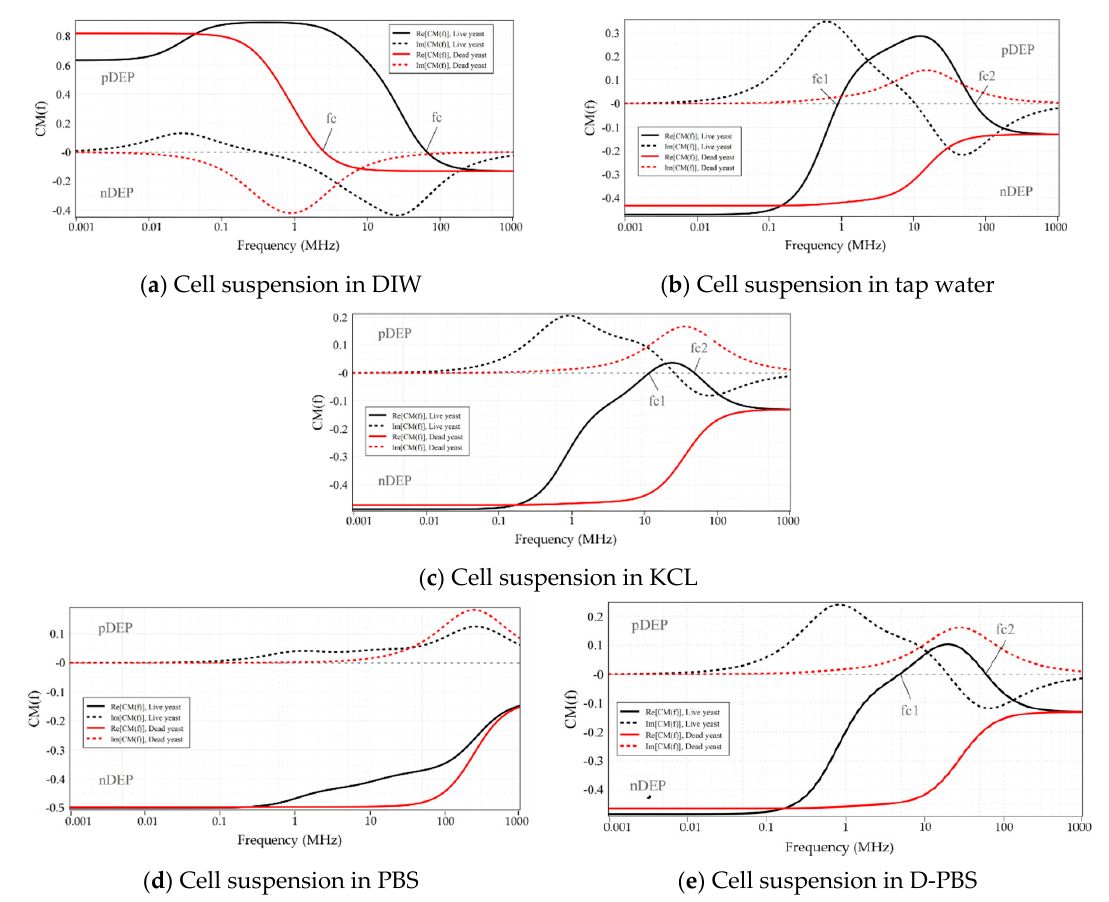
Figure 3. The Clausius-Mossotti factor as a function of frequency for live and dead yeast cells suspended in: ( a ) DIW; ( b ) Tap-water; ( c ) KCl; ( d ) PBS; ( e ) D-PBS. Electrical and geometrical properties of the live and dead yeasts were taken from [79]. Solid lines and dotted lines represent the real and imaginary parts of the Clausius-Mossotti factor, respectively.